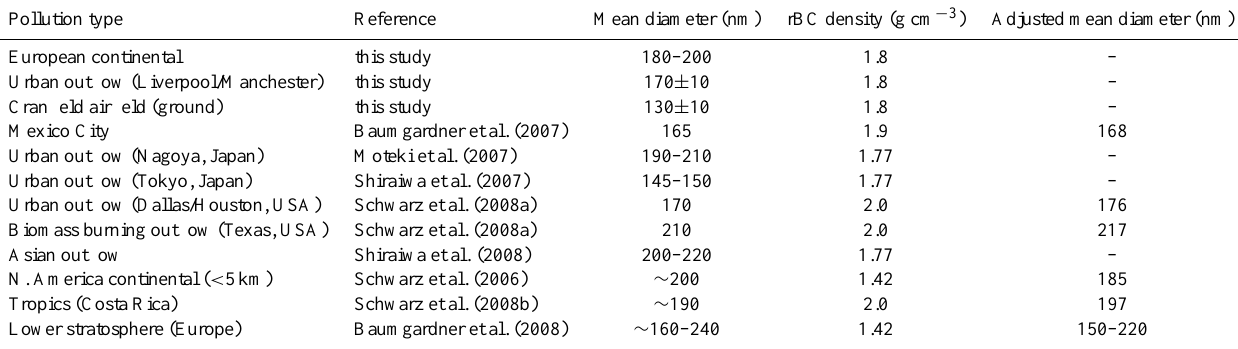
Table 5. Summary of refractory black carbon (rBC) mass size distributions measured by the SP2 in the boundary layer over Europe and for selected previous studies. If available, the standard deviation corresponding to the average of mean sizes observed is also reported. The mean diameters adjusted for an assumed rBC density of 1.8gcm − 3 are also